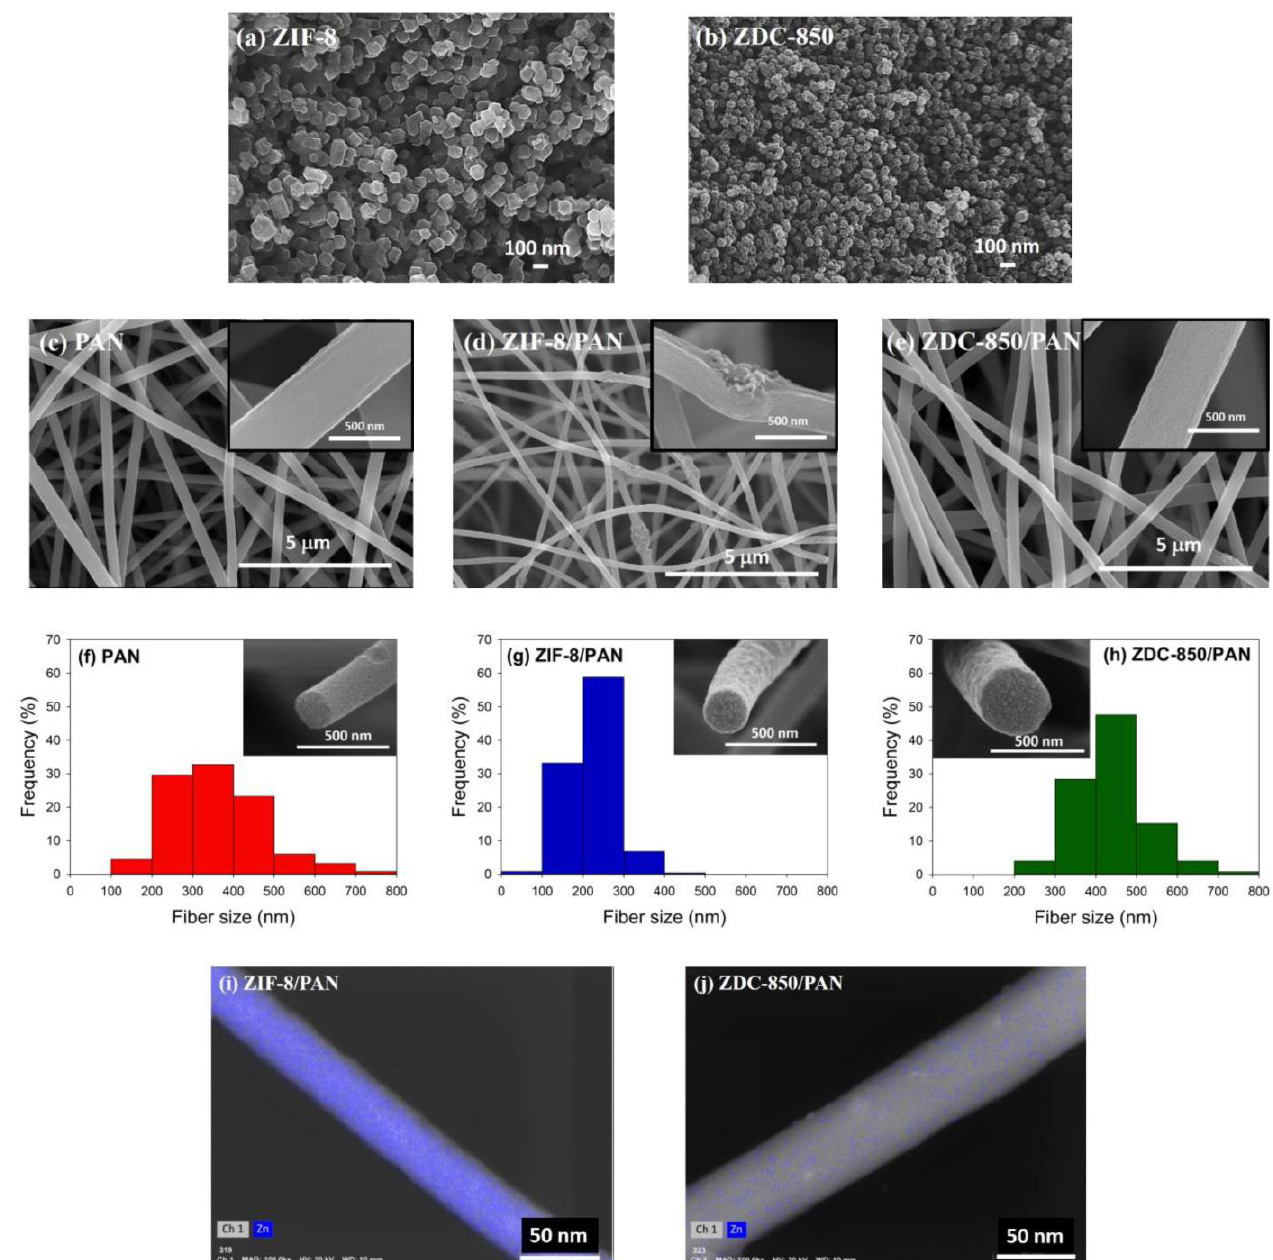
Figure 1. FESEM images, fiber size distributions, and the HRTEM-EDX mapping of the samples: ( a ) ZIF-8; ( b ) ZDC-850; ( c , f ) PAN; ( d , g , i ) ZIF-8/PAN; ( e , h , j ) ZDC-850/PAN.